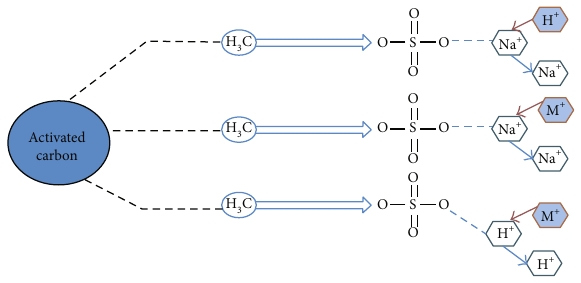
Figure 3: Chemical phenomenon for CV sorption onto ACMAS